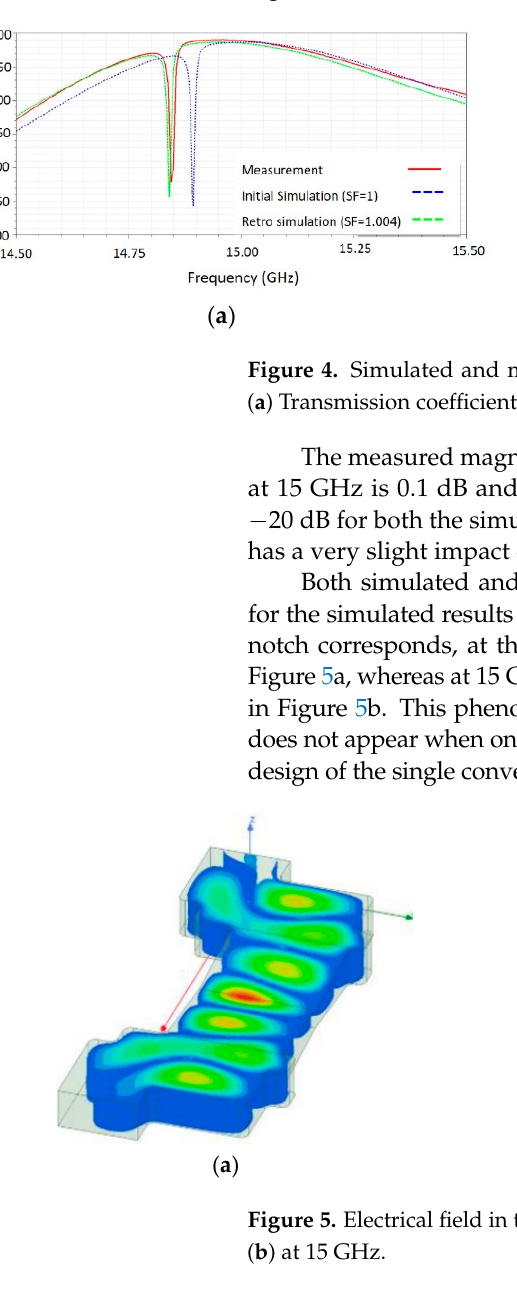
Figure 3. DMLS back-to-back TE10–TE20–TE10 mode converter.